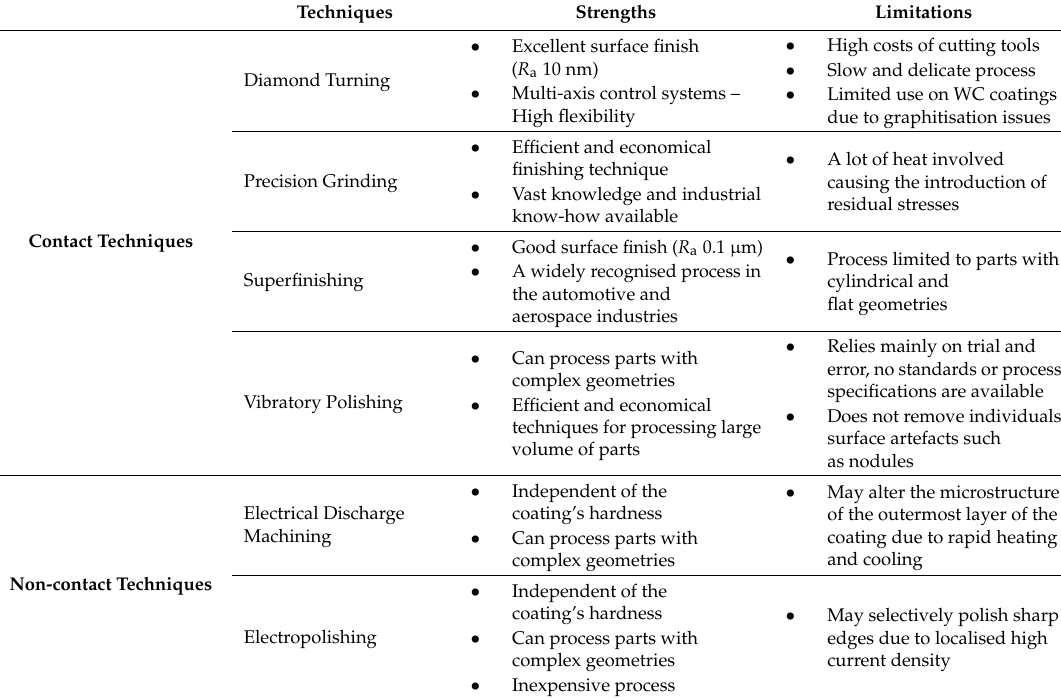
Table 3. Key strengths and limitations for contact and non-contact surface finishing techniques on WC